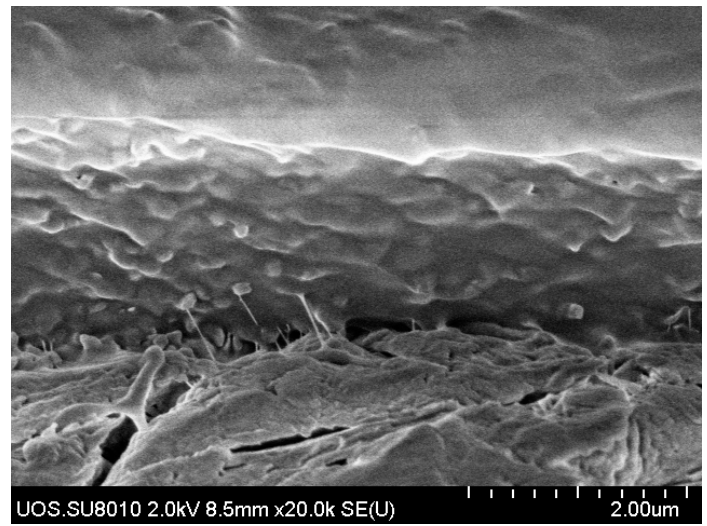
Figure 12. FE ‐ SEM images of the cross ‐ section of Pebax ‐ 2533/ZIF ‐ 7 25 wt% composite membrane. Figure 12. FE-SEM images of the cross-section of Pebax-2533/ZIF-7 25 wt% composite